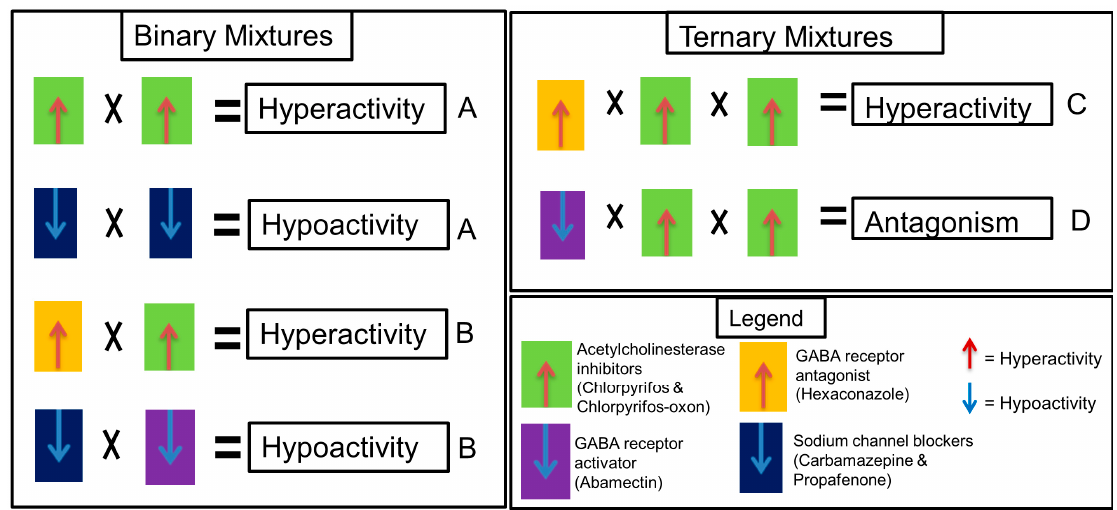
Figure 1. Mixture design scheme representing the hypotheses of this study. The letters A, B, C and D represent the mixture design according to Table 2. Each equation scheme for mixtures A, B and C represents a hypothesis whether concentration addition (CA) or independent action (IA) models could predict the hyper- or hypoactivity effects expected for mixtures with similar and dissimilar mechanisms of action. Equation for mixture D represents an antagonistic effect hypothesis. Table 2. Summary of the mixture design, observed toxicity and predicted toxicity.